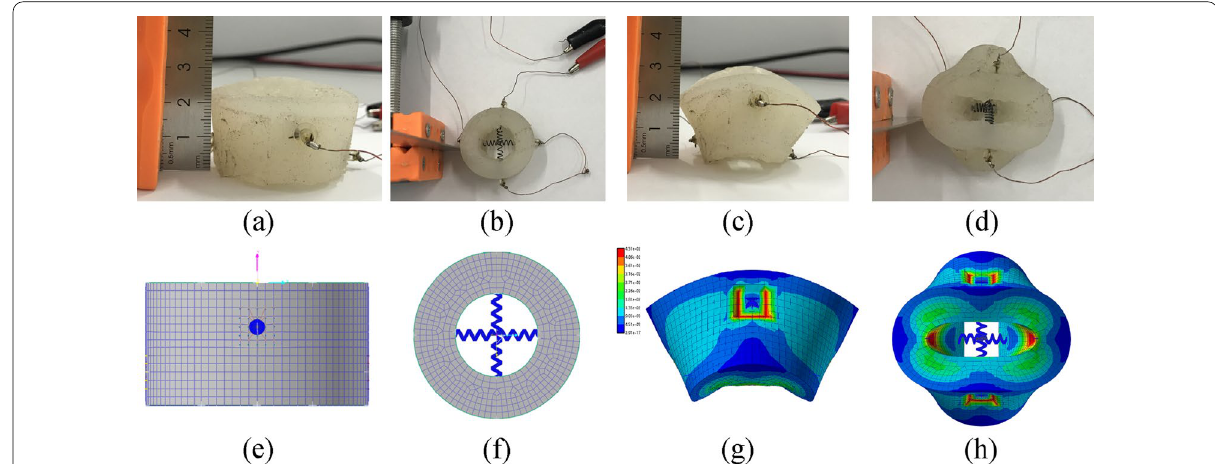
Figure 8 SMA spring actuation experiment and simulation